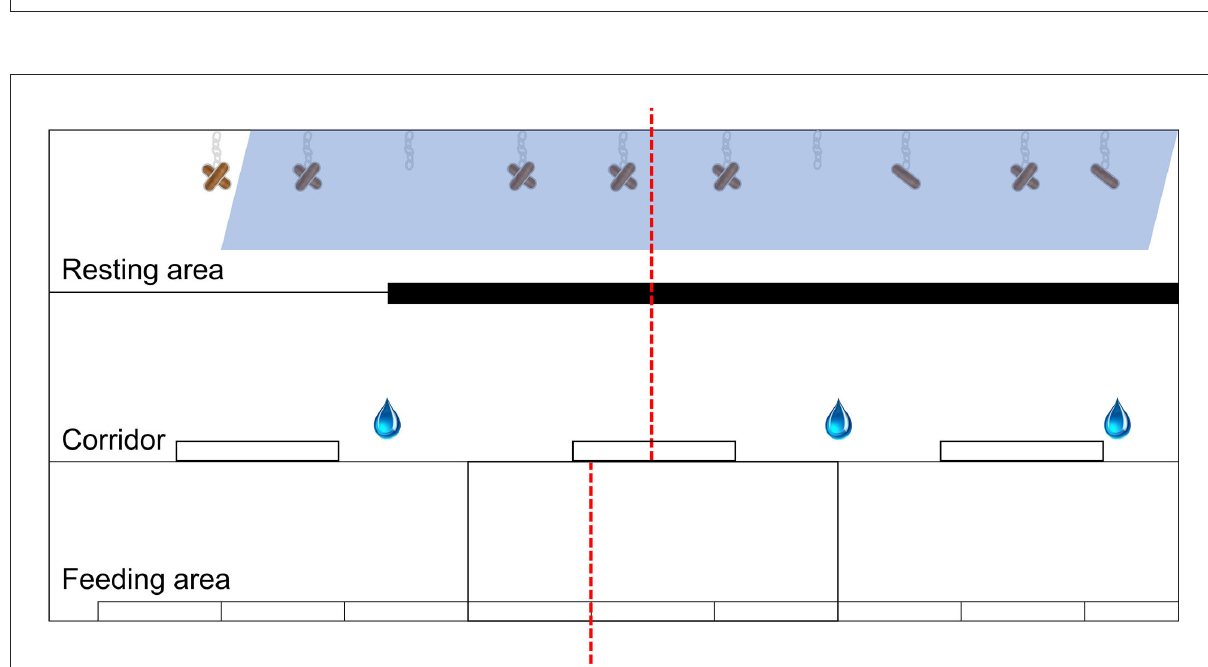
FIGURE2 Schematic diagram illustrating the three areas in the growing pen, including the feeding area (17.4*2.5m), corridor (17.4*2.6m), and resting area (17.4*2.5m). The blue shaded trapezoid in the resting area indicates the roof cover. Several wooden logs were hung from the wall by metal chains as drawn in the resting area. The narrow black rectangle indicates the gates where pigs could not pass between the resting area and corridor. The white rectangles in the corridor and feeding area indicate the feed troughs. The water droplets indicate the location of nipple drinkers. The red dashed lines indicate the division of the pen into separate observation sectors for live behavioral observation (feeding 1, corridor 1, and resting 1 to the right; feeding 2, corridor 2, and resting 2 to the left).